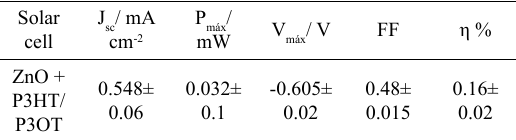
Table 1. Parameters obtained from the j-V curves of ZnO cell sensitized with copolymer P3HT/P3OT Solar